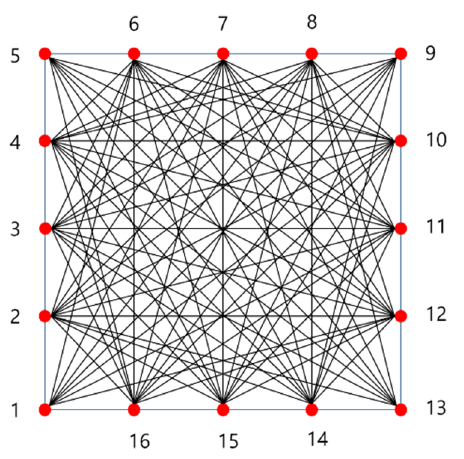
Figure 5. Propagation network for the tomographic image.